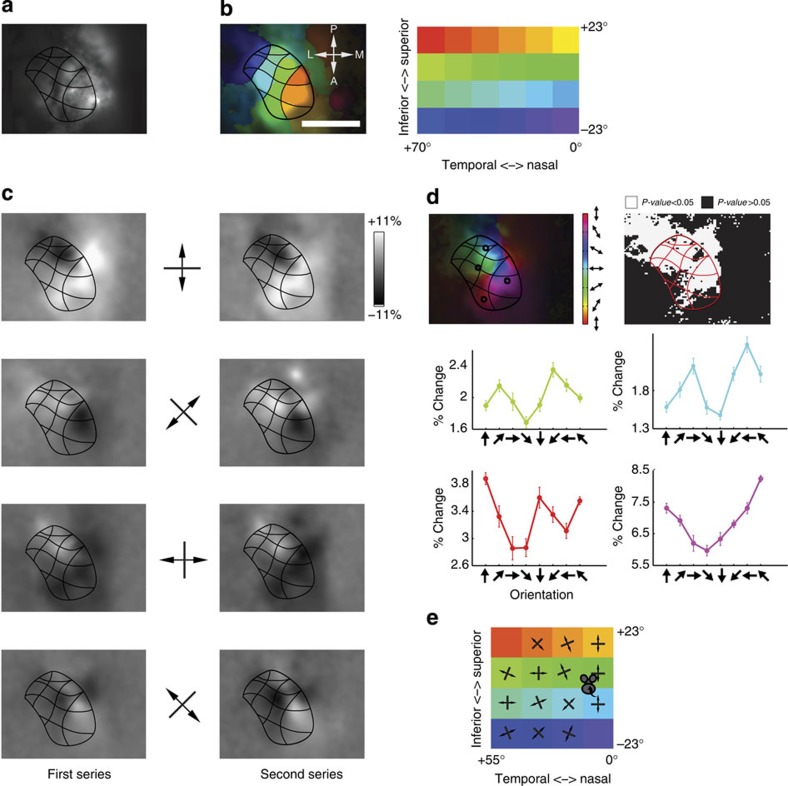
Orientation preference is dependent on retinotopic position.(a) Image of GCaMP6 fluorescence in the sSC after neocortex has locally been aspirated. (b) Retinotopy in sSC. Each pixel is coloured corresponding to the monitor patch to which it gave most response. Pixel saturation scales linearly with response strength. Maximum ΔF/F was 8%. A smooth mesh was drawn over the boundaries of the monitor patch representations. This mesh was added to the other panels only as a visual aid. Scale bar is 1 mm. (c) The difference of the average response for each set of orientations and the average response to all orientations shows regional differences, which are very consistent for the first set of 10 (left) and next set of 10 presentations (right). (d) Left top panel shows polar map of sSC, where each pixel is coloured to its angular preference. Saturation scales linearly with response strength. Maximum ΔF/F was 7%. The map shows a smooth change covering all angles once. For the four indicated locations (each disk with a radius of 40 μm, covering area of 40 pixels) at different corners of the responding region, the response to all directions are shown at the bottom. Error bars in tuning curves are mean±s.e.m. Right top panel shows the significance of the preference of each sSC pixel for any of the four orientations. P-values of the white pixels are less than 0.05. (e) For each patch in the retinotopy of b, the preferred orientation is computed and shown on the equivalent part in visual space. This reveals a preference for concentric orientations.